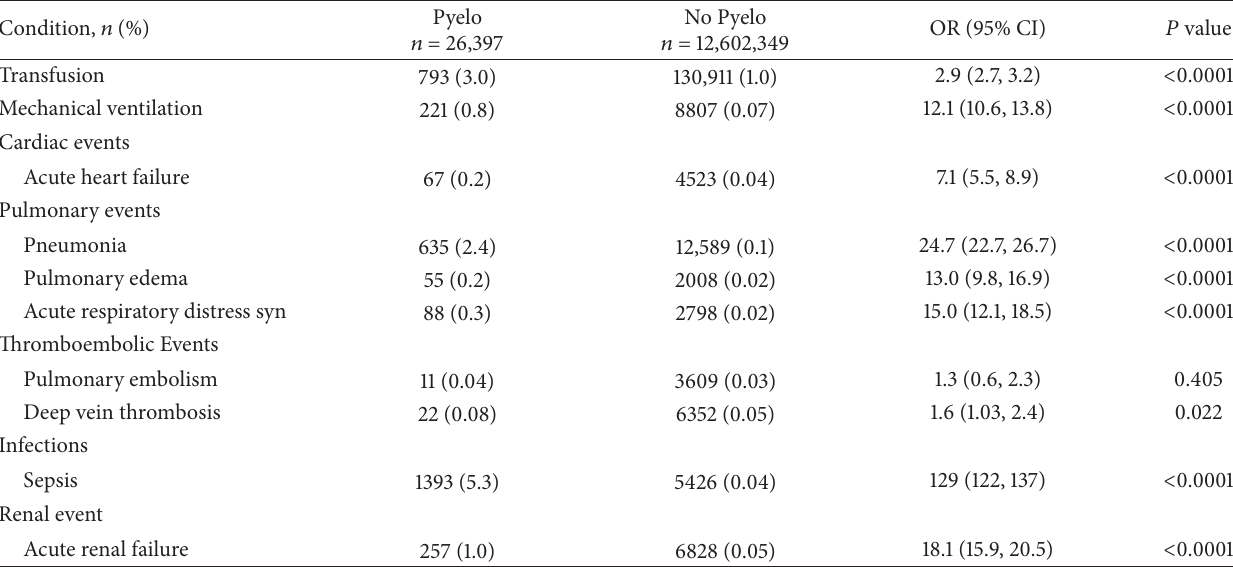
Table 3: Medical events present at time of delivery in hospital discharges among women with pyelonephritis compared to women without pyelonephritis, Nationwide Inpatient Sample years 2008–2010 (12,628,746 deliveries).